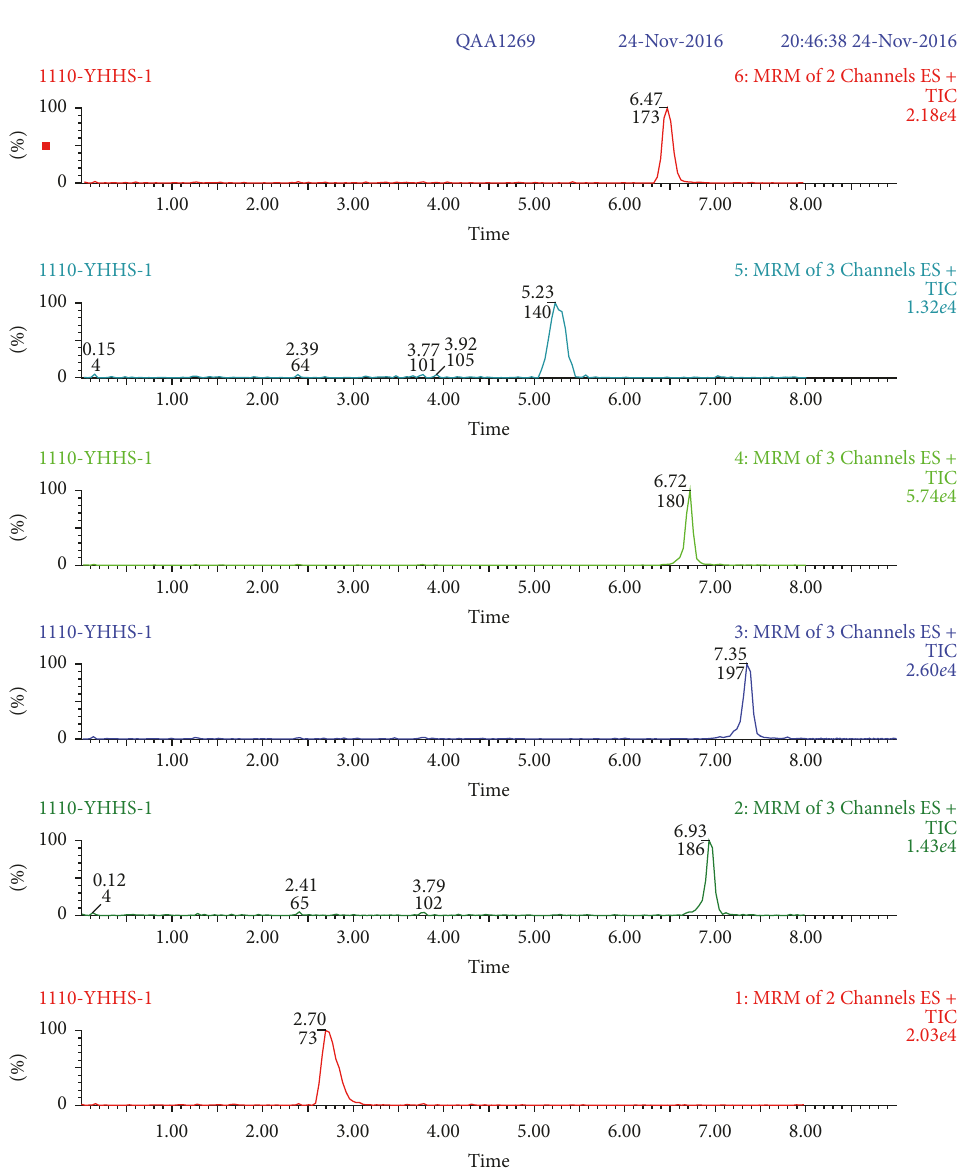
Figure 4: Typical chromatograms of MRM transitions for metronidazole, tinidazole, ornidazole, ofloxacin, ciprofloxacin, and enrofloxacin at the concentration of 25 𝜇 g/kg in acacia